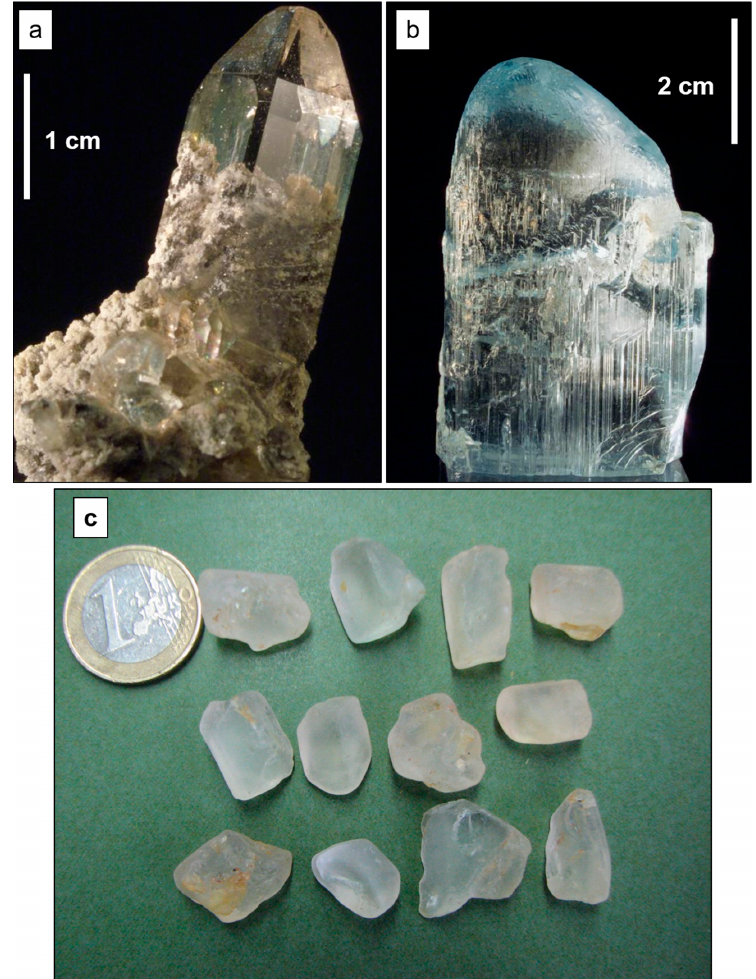
Figure 11. Topaz crystals—from the primary deposit to the secondary deposit in placers. ( a ) Euhedral well-crystallized transparent topaz from Thomas Range, Utah, USA. ( b ) Subhedral crystal with beveled edges, Brazil. ( c ) Anhedral detrital topaz from eluvial placer deposits in the Rondonia tin mining district, Brazil. Two processes, tectonic uplift and unroofing, controlled the variation of heavy minerals (Dill 1995) [76]. When the relief is low, the chemical weathering intensive and the erosion is slow meteoric